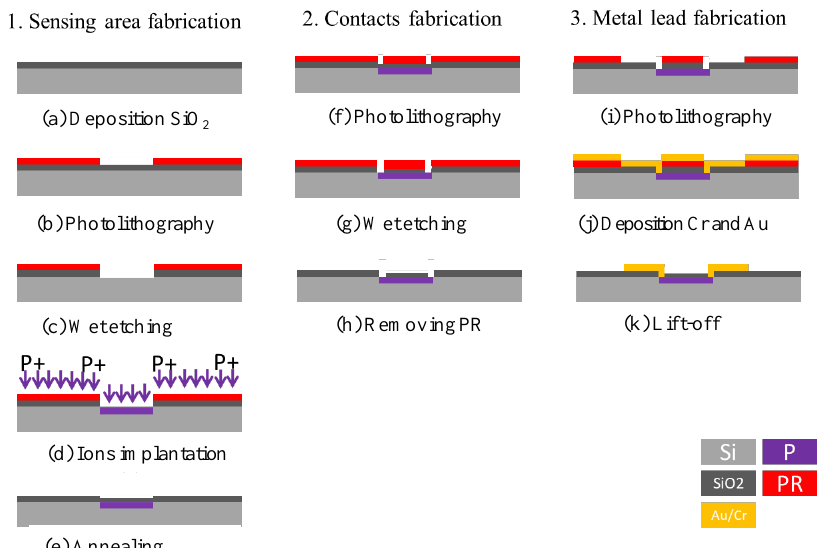
Figure 4. Schematic illustration showing the main steps of the fabrication process of Hall sensor: ( a ) deposition of SiO 2 , ( b ) photolithography, ( c ) wet etching, ( d ) ion implantation, ( e ) annealing, ( f ) photolithography, ( g ) wet etching, ( h ) removing PR, ( i ) photolithography, ( j ) deposition of Cr and Au, and ( k ) lift-off.